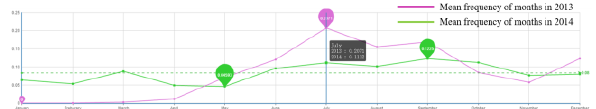
Figure 10 Mean frequency of ISIS from January to December in 2013 and 2014